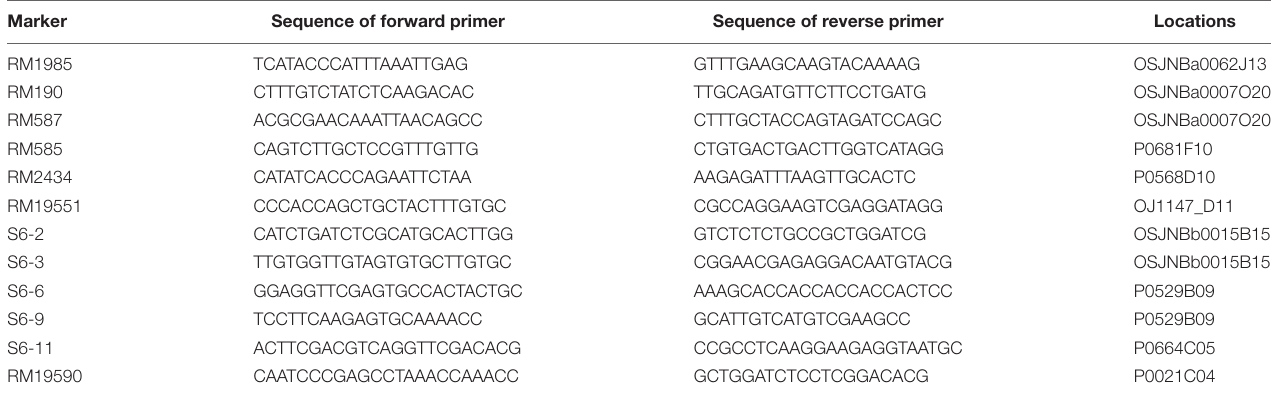
FIGURE 9 | Genetic and physical maps of the qPa-6-2 gene. (A) Primary mapping of the qPa-6-2 gene. The gene was mapped to the region between markers Ind6-1 and RM276; (B) Further mapping of the qPa-6-2 gene. The gene was mapped to the region between markers RM19551 and RM19590; (C) Fine mapping of the qPa-6-2 gene. The qPa-6-2 gene was finally defined in an 88 kb region, and the recombinants number between markers and target gene was indicated under the physical distance. TABLE 5 | Simple sequence repeats and Indel molecular marker developed for qPa-6-2 gene mapping. Marker Sequence of forward primer Sequence of reverse primer